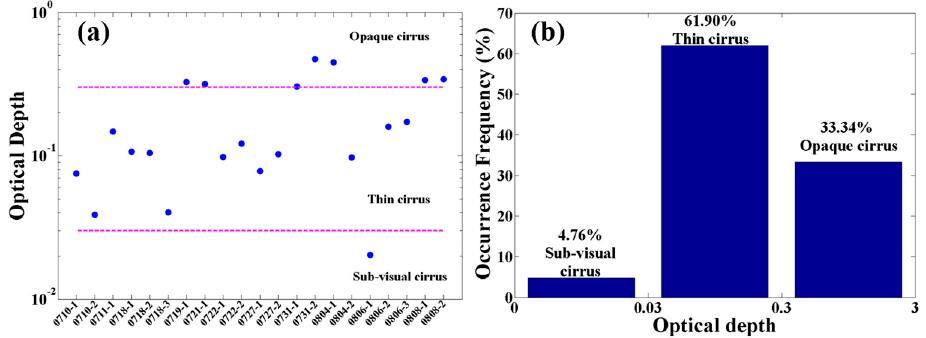
Figure 4. ( a ) Distribution of optical depth and the classification, ( b ) Occurrence frequency of different Figure 4. (a) Distribution of optical depth and the classification, (b) Occurrence frequency of different types of cirrus types of cirrus clouds.